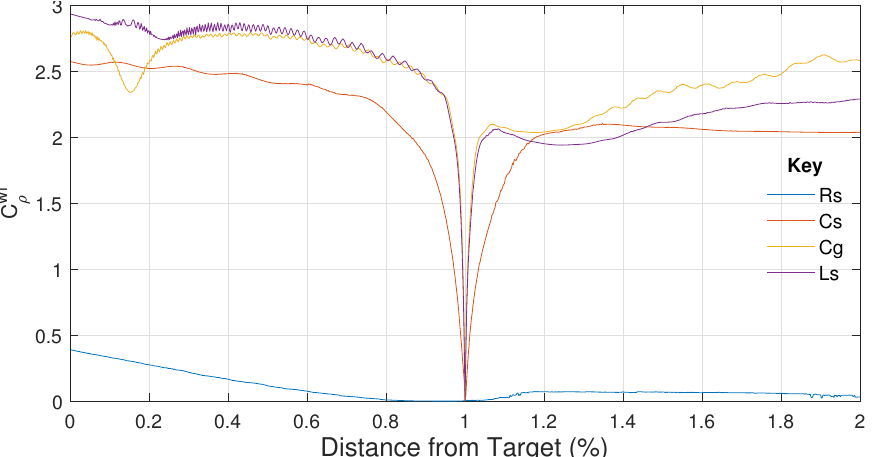
Figure 11. Weighted Inferred EMD Cost Function C wi ρ versus Distance from Target